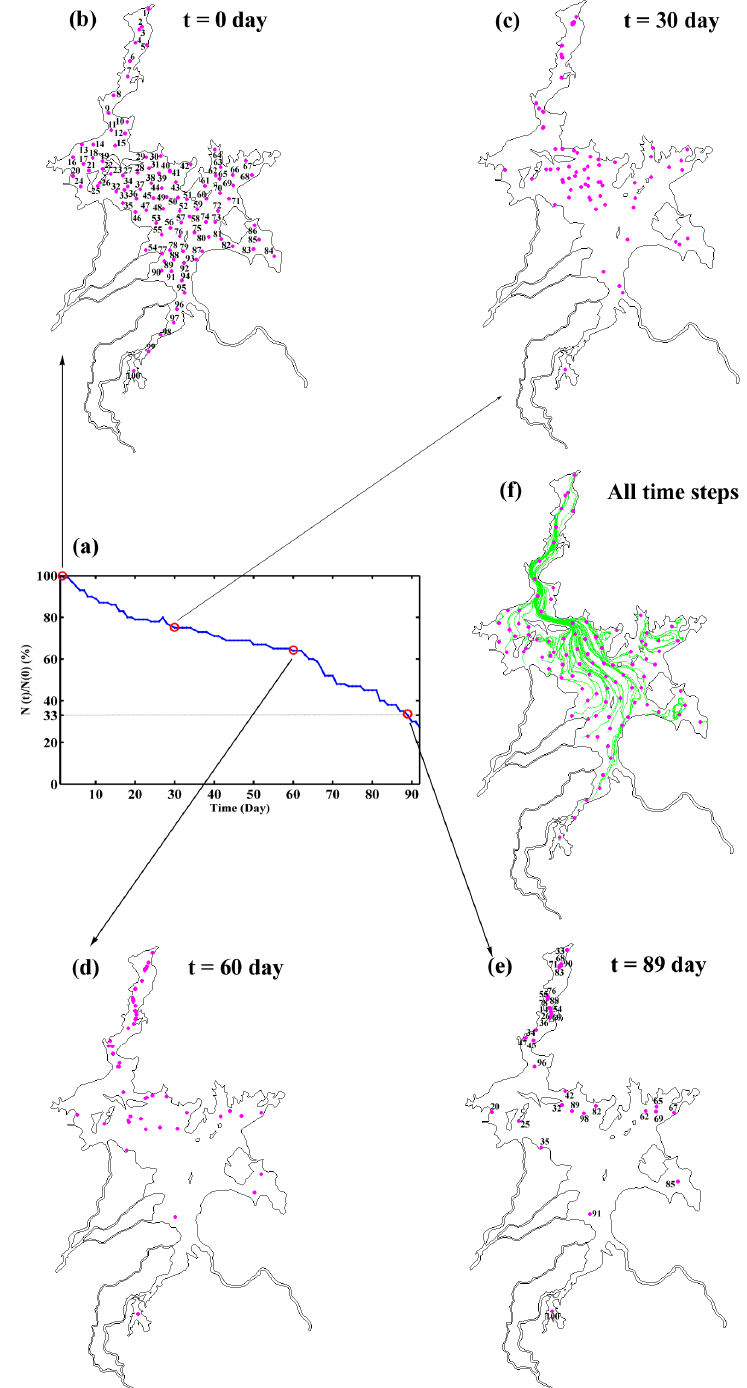
Figure 5. ( a ) The number of particles left in the lake relative to the initial numbers (in pink dots). Particle patterns after ( b ) 0, ( c ) 30, ( d ) 60, and ( e ) 89 days and ( f ) trajectories of all particles (in green lines) during the simulation periods. The marked numbers represent the Particle